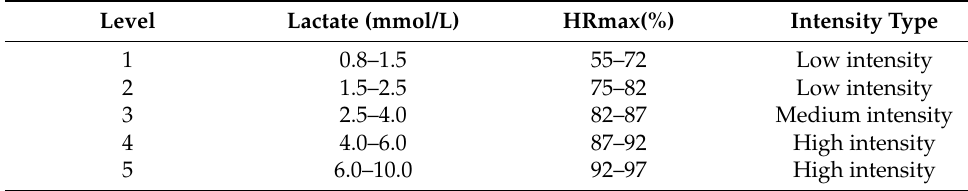
Table 2. Training intensity levels for cross-country skiers.